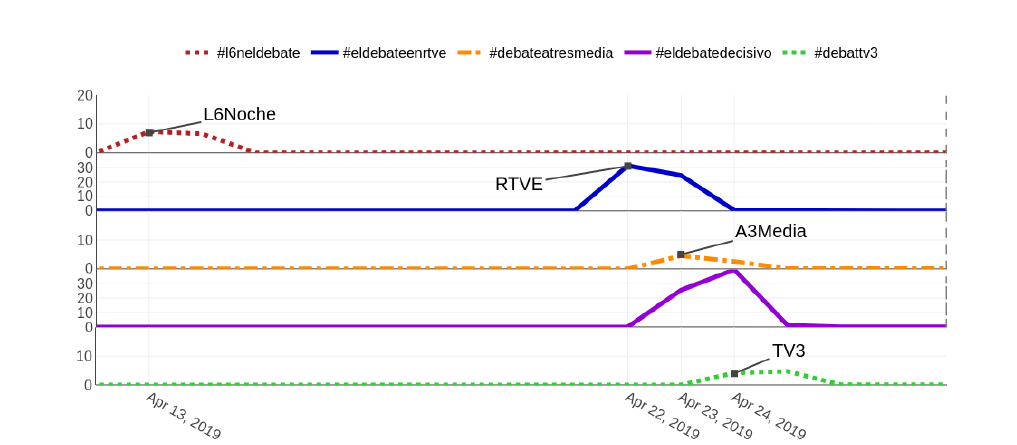
Figure 12. Daily relative amount of tweets extracted using the hashtags for each political debate in percentage (#l6neldebate, #eldebateenrtve, #debateatresmedia, #eldebatedecisivo, and #debattv3). For the purposes of clarity, notice that the y-axis scale is not equal across all